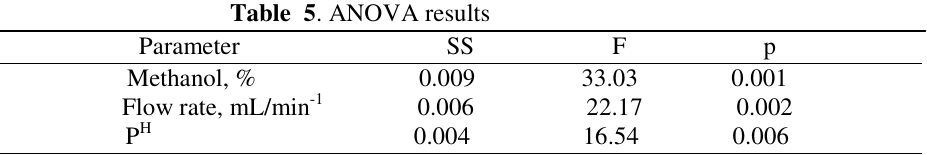
Table 6 . Experimental plan for Intermediate precision testing and obtained responses Exp.